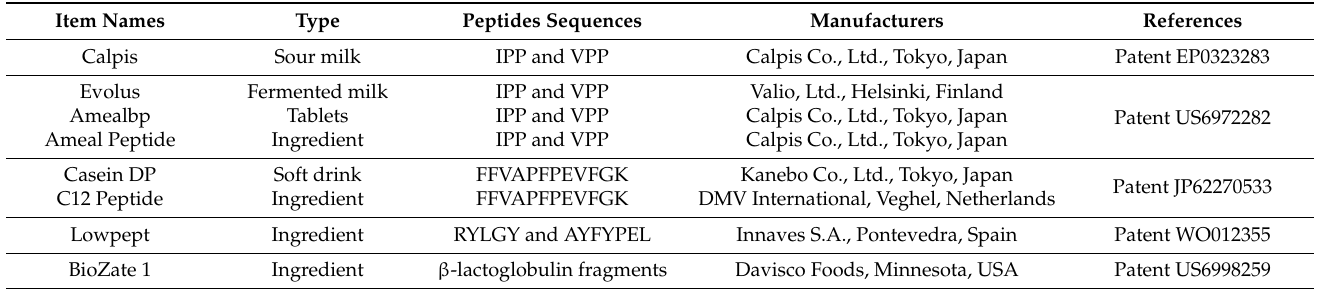
Table 5. Commercial products containing cardioprotective peptides derived from